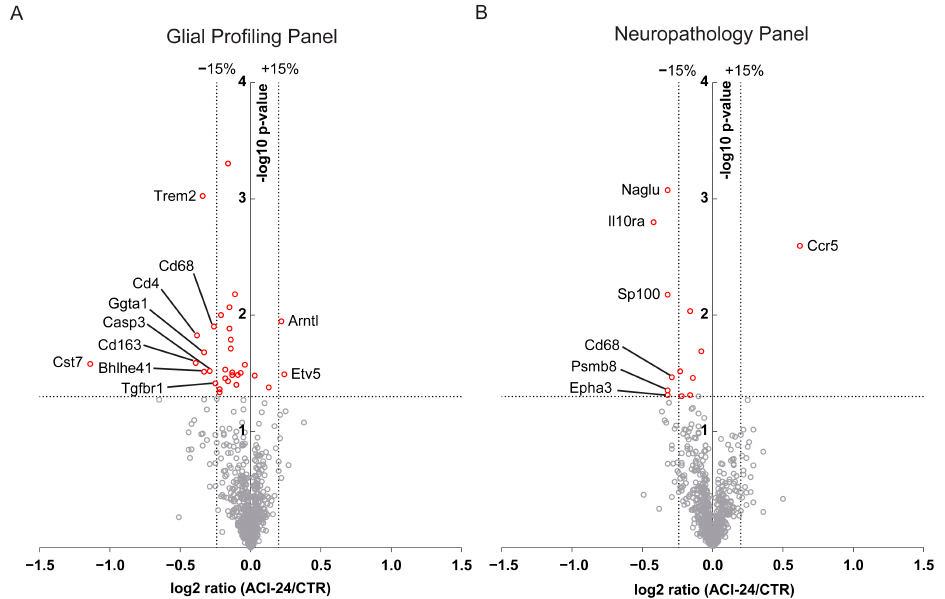
Figure 4. Bulk transcriptomic analysis from cerebrum of 6 ACI-24 vaccinated and 5 control mice (transgenic mother offspring). Volcano plots depict differentially expressed genes with the nCounter Glial Profiling Panel ( A ) and Neuropathology Panel ( B ). The negative log10 transformed p -value is plotted against the mean log2 transformed ratio between ACI-24 vaccinated and control animals. Horizontal dotted line depicts the p -value of 0.05, while the vertical lines represent changes in the expression of 15% as annotated. Genes with the p -value less than 0.05 are marked in red, while in